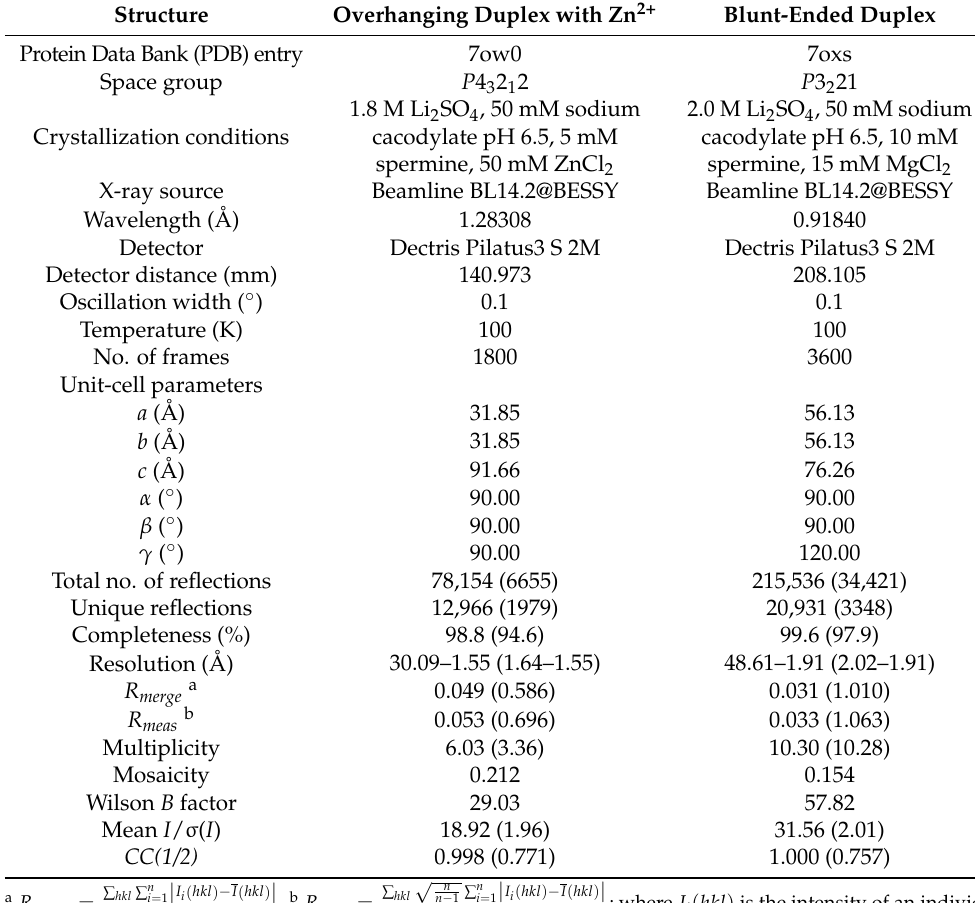
Table 1. Crystallographic parameters and data-collection statistics. Values in parentheses correspond to the highest resolution shell. Structure Overhanging Duplex with Zn 2+ Blunt-Ended Duplex Protein Data Bank (PDB)